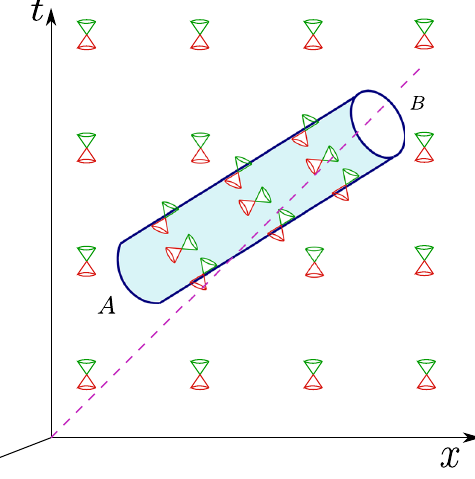
Fig. 2 The figure represents a warp drive tube that starts in a location A and ends in location B. The underlying spacetime can be considered D + 1 dimensional with the warp-drive bubble moving in a straight line (along the x -coordinate, in the picture). In 1 + 1 dimensions the causal cone would become just two crossing lines but we keep the cone symbol for clarity. This is the simplest construction of a warp drive and asdescribedinthetext,itcanbesimulatedinananalogue gravitymodel without further